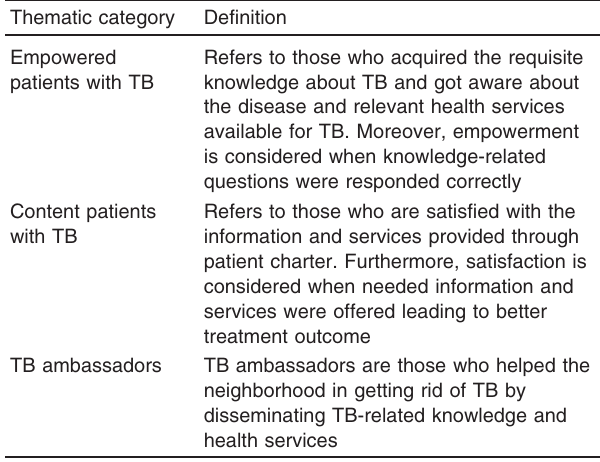
Table 2 Thematic categories and their definitions evolved through this